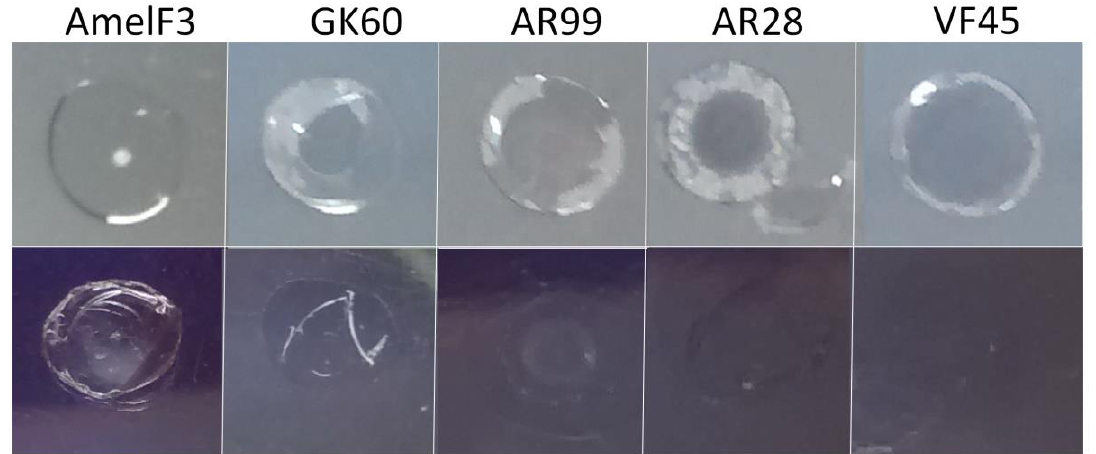
Figure 9. Images of films cast from full-length honeybee silk protein (AmelF3), and peptides from different regions (Figure 1). Top panel , as cast films; Bottom panel , after aqueous methanol treatment, where materials cast from peptides have dissolved and are no longer obvious.